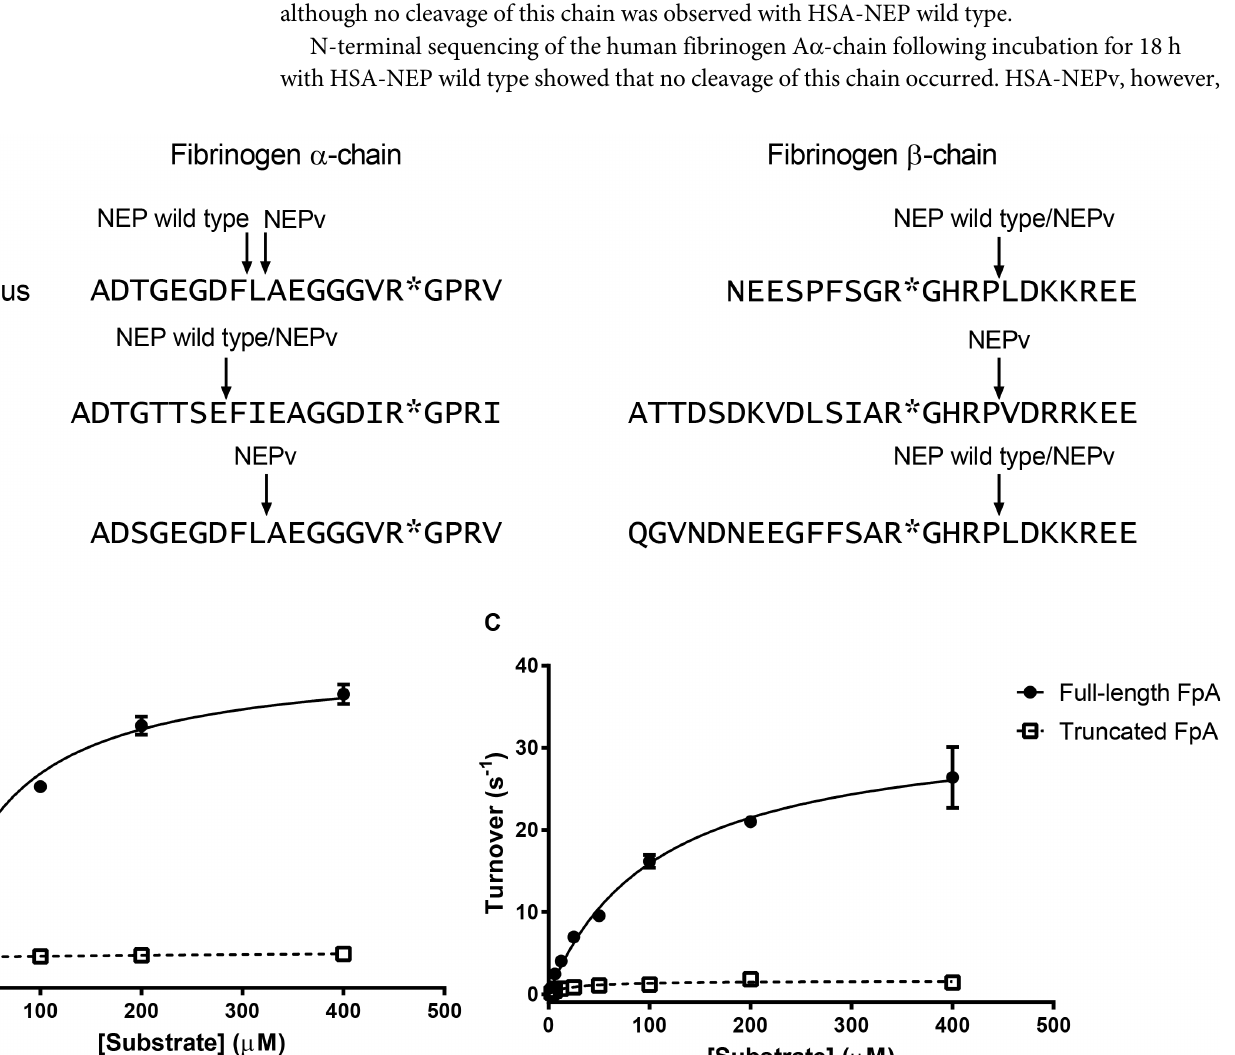
Fig 4. Effect of NEP on fibrin formation. Human fibrinogen was incubated with a range of concentrations of HSA-NEPv (A), HSA-NEP wild type (B) or HSA-NEP E584V (C) for 4 h after which fibrin formation was initiated by the addition of thrombin and CaCl 2 and OD 405 was measured for 45 min (mean ± SD; n = 2).